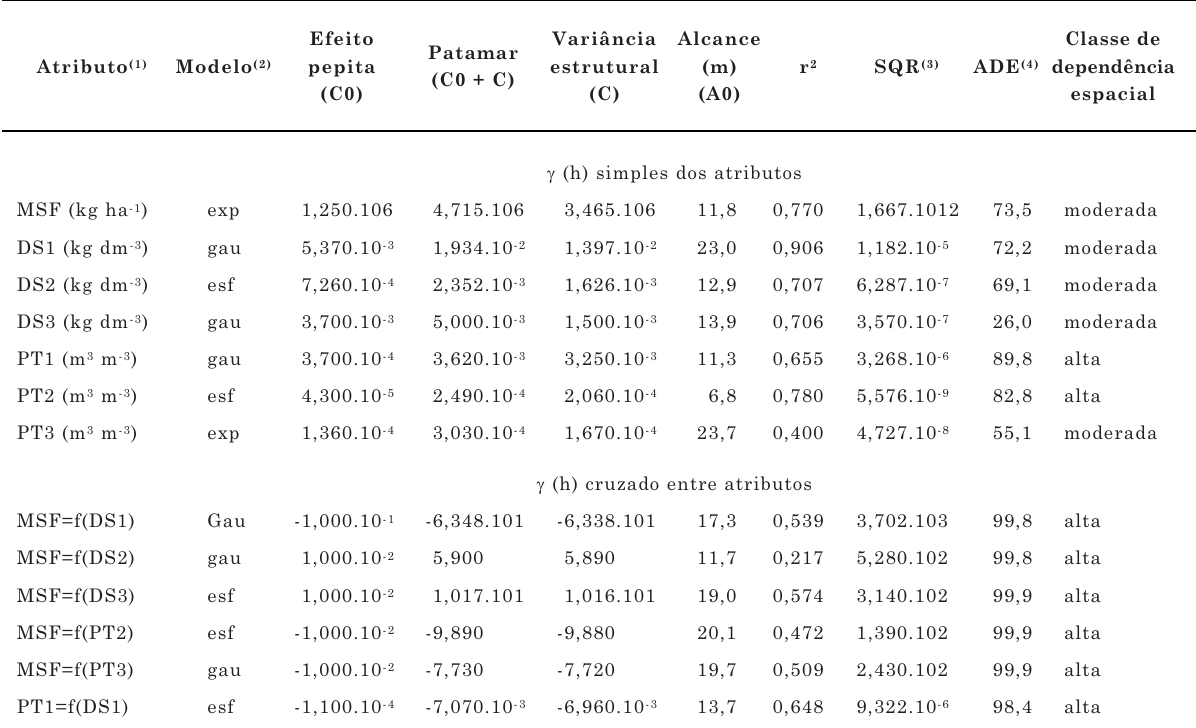
figura 1a,b, onde ocorreu substancial elevação da densidade do solo na primeira camada